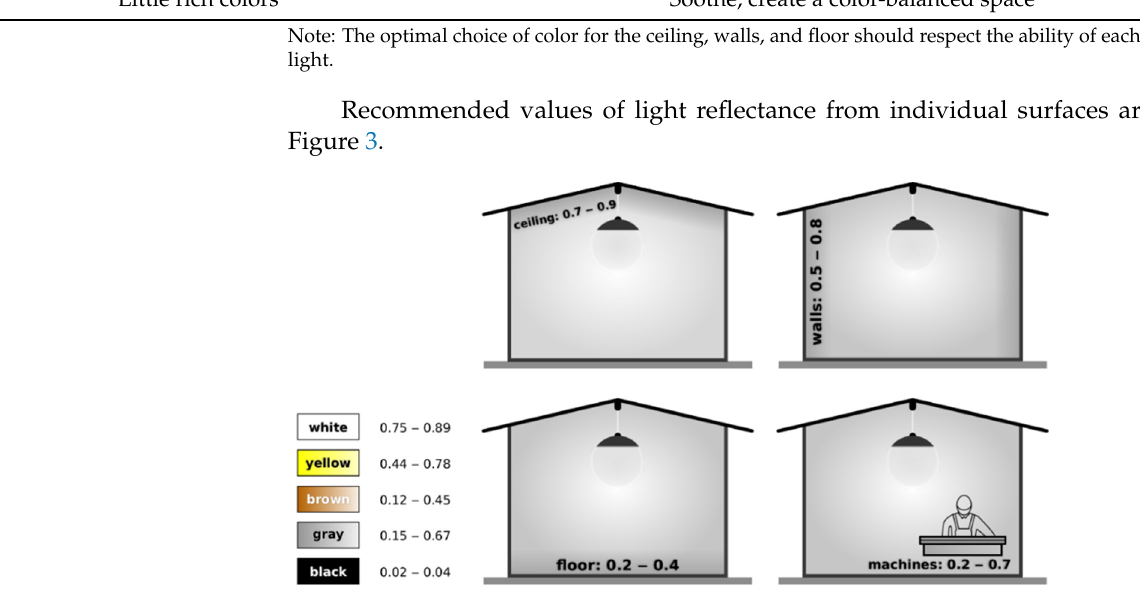
Table 1. Psychophysiological effect of colors.